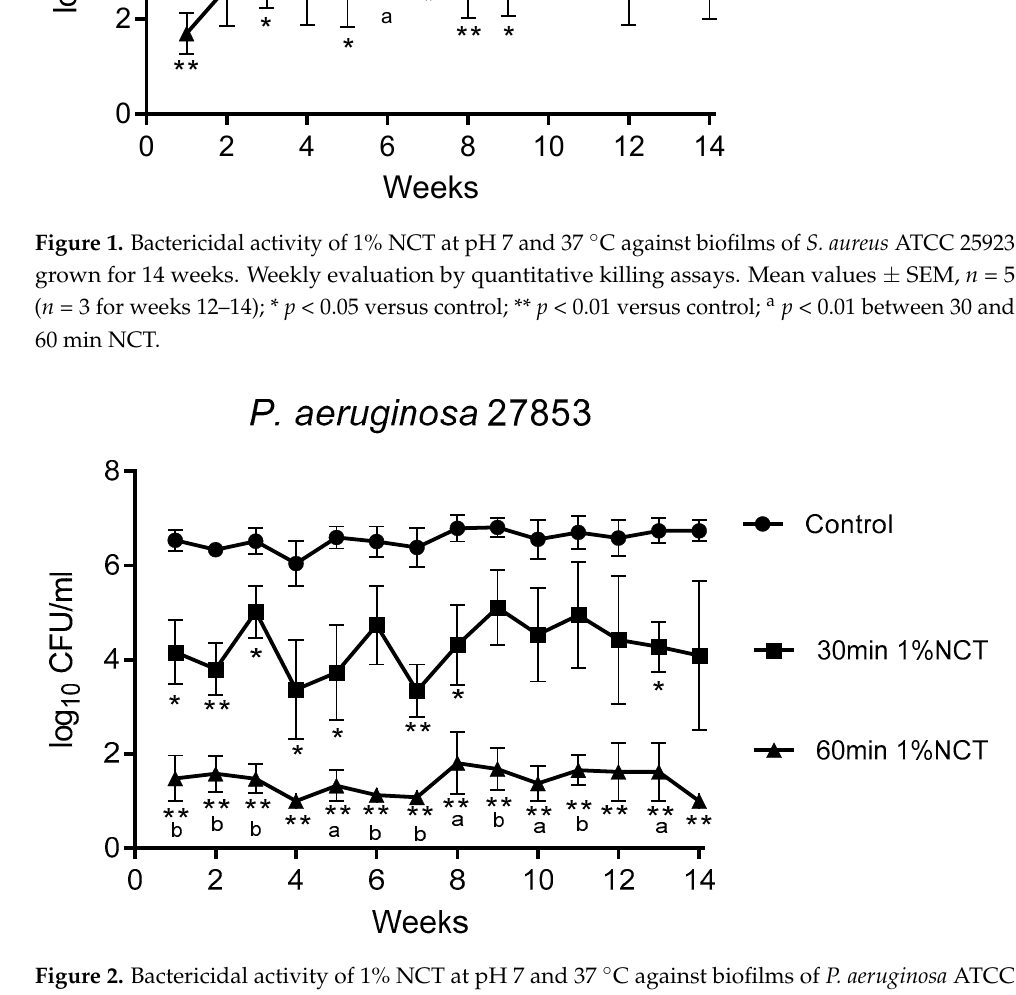
Figure 3. Bactericidal activity of 1% NCT at pH 7 and 37 °C against biofilms of K. variicola clinical isolate grown for 14 weeks. Weekly evaluation by quantitative killing assays. Mean values ± SEM, n = 5 ( n = 4 for weeks 12–14); p < 0.01 for all values of 30 min and 60 min NCT versus control except for p < 0.05 for 30 min NCT after 4 weeks; * p < 0.05 versus control; ** p < 0.01 versus control; a p < 0.05 of 30 min versus 60 min NCT. The absence of a change of susceptibility over time allowed a calculation over all single values, which is shown in Figure 4. The overall reduction in CFU was highly sig- nificant for 30 and 60 min NCT for all strains, coming to 0.91 and 2.83 for S. aureus , 2.27 and 5.13 for P. aeruginosa , and 4.74 and 5.58 for K. variicola , respectively (Figure 4).